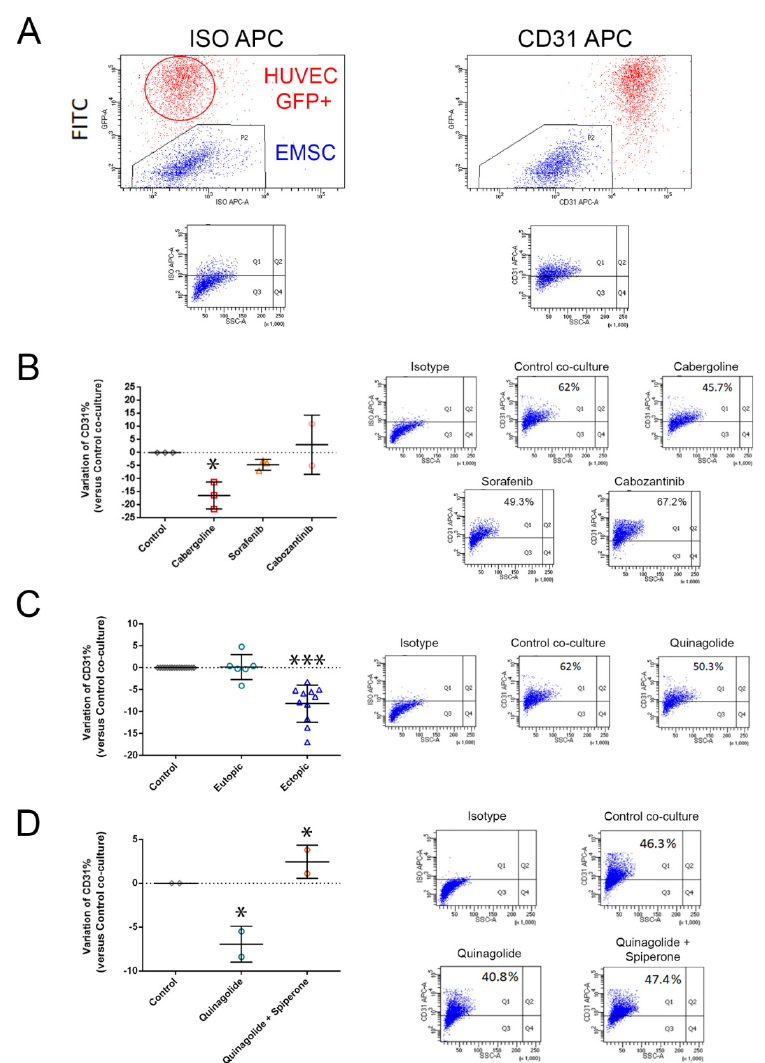
Figure 5. Quinagolide effect on E-MSC endothelial differentiation. ( A ) FACS gating strategy for the analysis of CD31 + E-MSCs after direct 48 h co-culture with HUVECs. E-MSCs are gated as GFP neg- ative population, and CD31 expression is evaluated on the described gated E-MSCs after 48 h co- culture with HUVECs as percentage of CD31 APC positive events. ( B – D ) Representative flow cy- tometry micrographs and quantification, expressed as percentage of variation respect to control co- culture, of the effect of 24 h treatment of E-MSCs with 25 µM cabergoline, 1 µM sorafenib, 1 µM cabozantinib ( B ), 100 nM quinagolide ( C ) and the combination of 5 µM spiperone and 100 nM quinagolide ( D ) on E-MSC CD31 expression after 48 h of co-culture with HUVECs. Data are repre- sented as mean ± SD of at least three independent experiments, performed on different ectopic E- MSC lines, and normalized to untreated co-culture. One-way ANOVA was performed: * = p < 0.05 and *** = p < 0.001 vs. control.